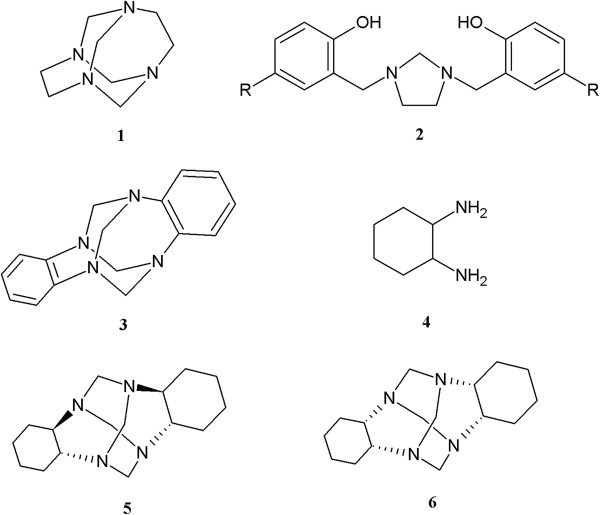
Structures of 1-6.